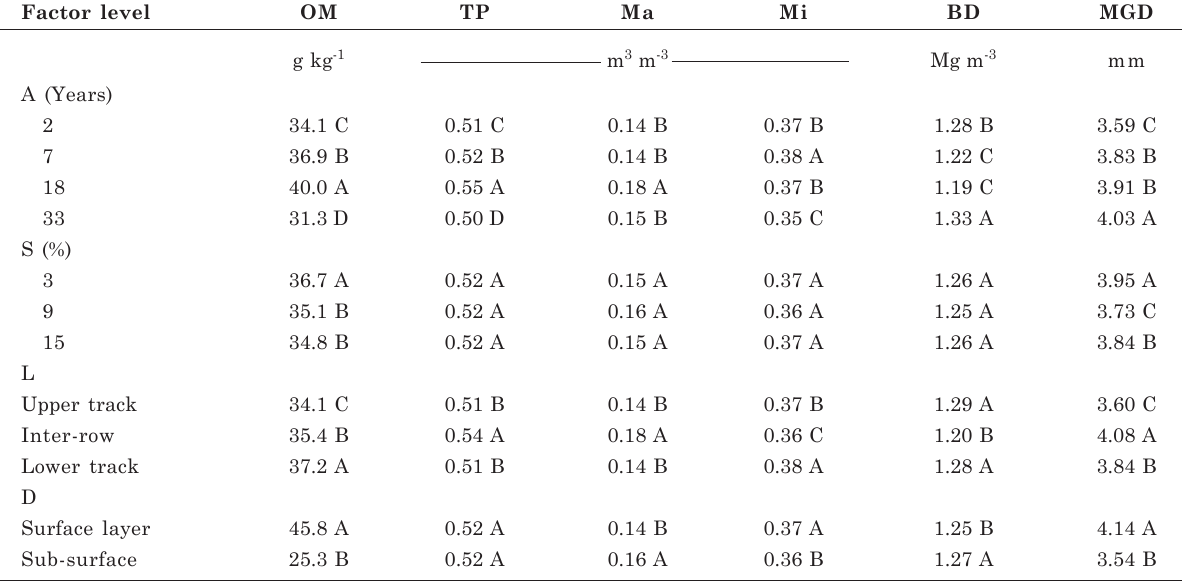
Values followed by different letters in each column are significantly different by the Scott-Knott test at 5 %. Split plot experiment with 216 experimental points, four ages of coffee plantations, three slopes, three sampling locations at two depths, with three